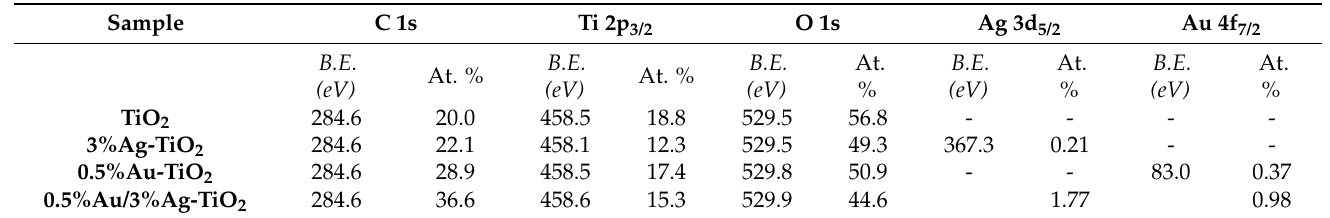
Table 2. XPS survey analyses of bare TiO 2 , monometallic 3%Ag-TiO 2 and 0.5%Au-TiO 2 , and bimetallic